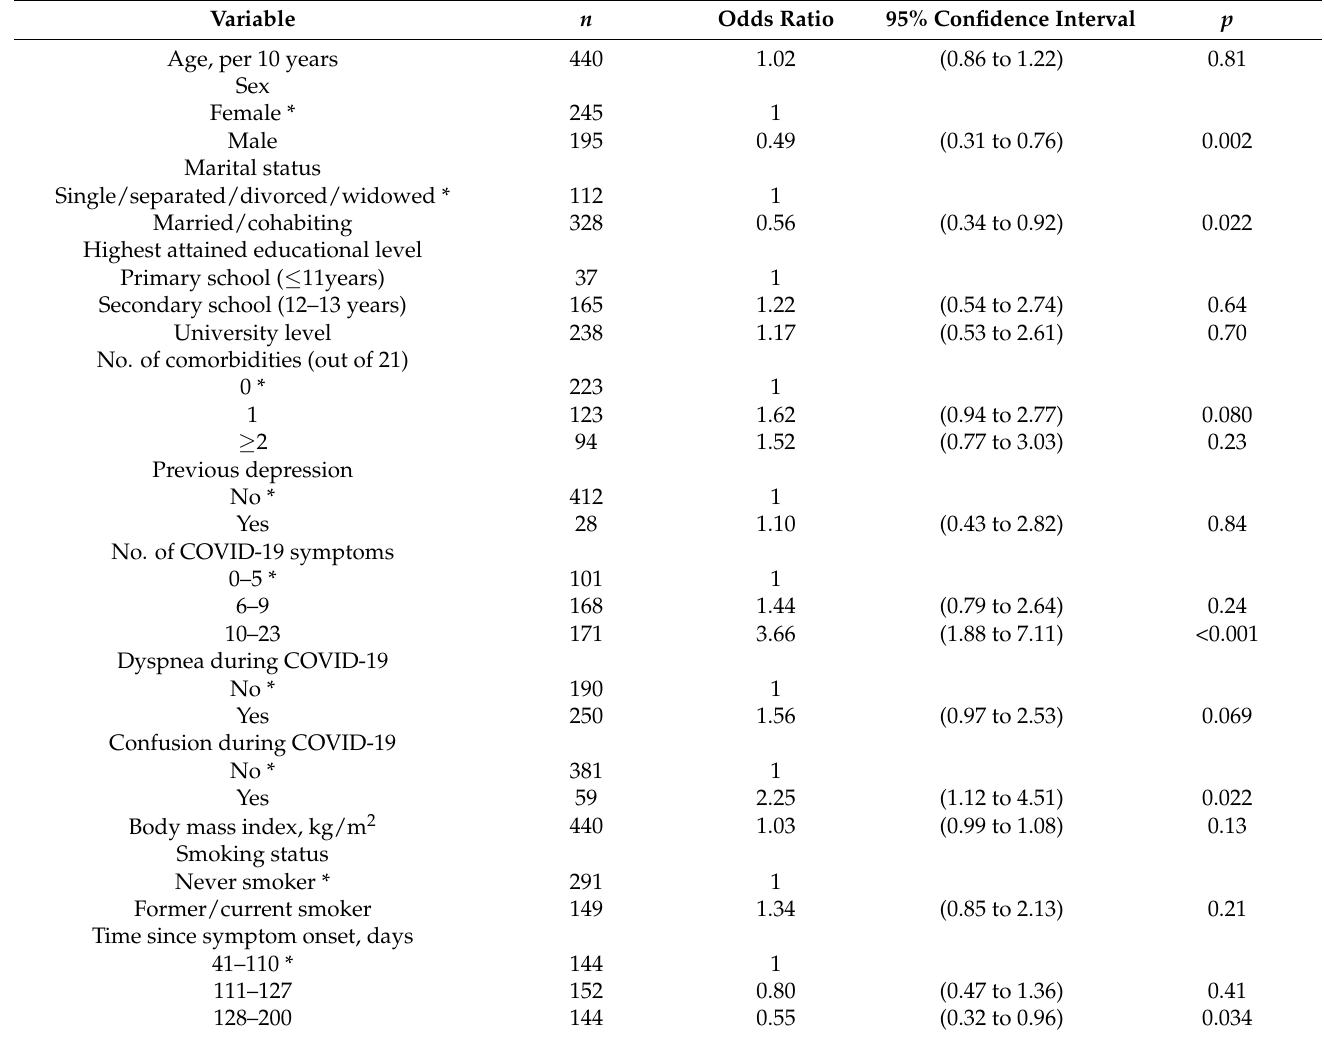
Table 2. Determinants of fatigue (defined as CFQ-11 bimodal score, >3 vs. 0–3), multivariable logistic regression analysis ( n = 440).